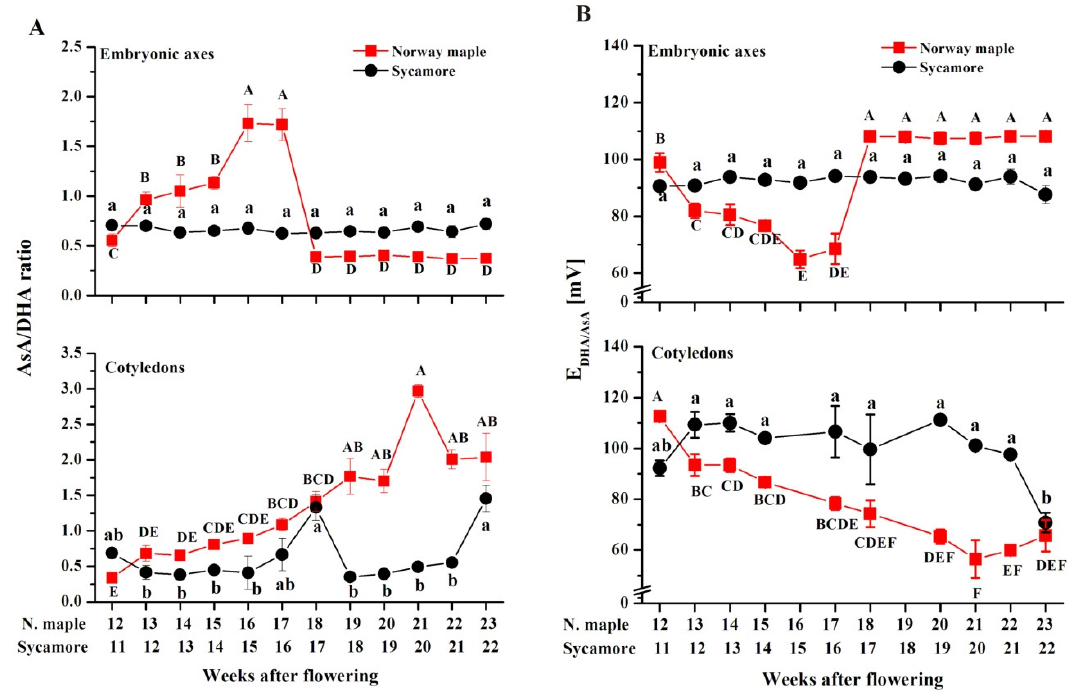
Figure 11. Changes in the ratios of reduced (AsA) to oxidized (DHA) forms of ascorbate ( A ) and half-cell reduction potential (E DHA / AsA ) of ascorbate ( B ) in the embryonic axes and cotyledons of developing seeds of Norway maple (squares) and sycamore (circles) collected during the 11th–23rd weeks after flowering. Data are the means of three independent replicates ± the standard error. Statistically significant di ff erences are indicated with di ff erent letters (one-way ANOVA, followed by Tukey’s test at p < 0.05). The capital letters refer to Norway maple.